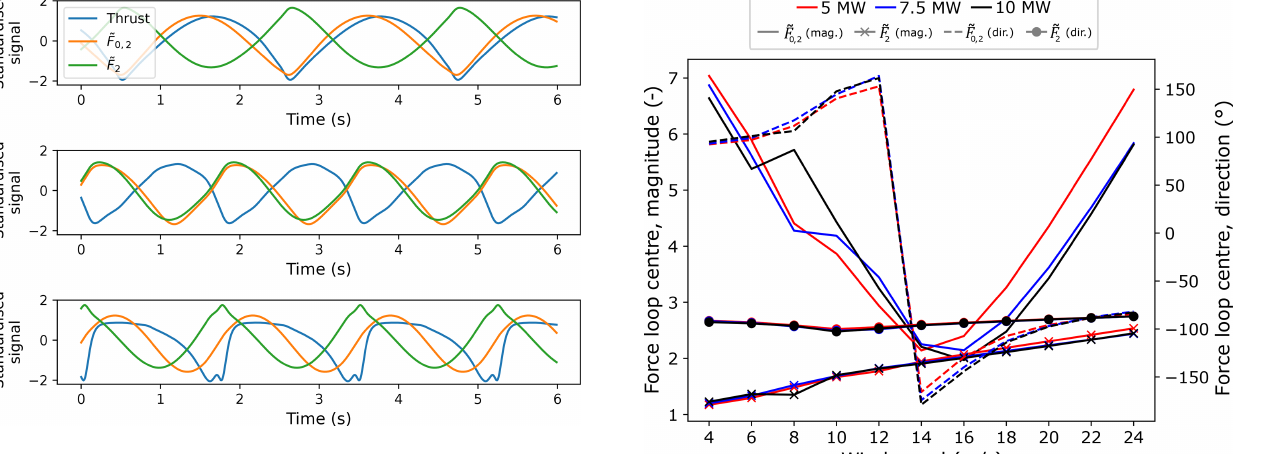
Figure 6. Time series of thrust and main-bearing row radial force response magnitudes in overhung ( ˜ F 0 , 2 ) and centred ( ˜ F 2 ) configu- rations. All outputs are presented as standardised signals, allowing for easy consideration of correlations. From top to bottom, wind field characteristics are v = 8ms − 1 and α = 0 . 2, v = 18ms − 1 and α = 0 . 2, and, finally, v = 10ms − 1 , α = 0 . 2, and ϕ = − 20 ◦ .